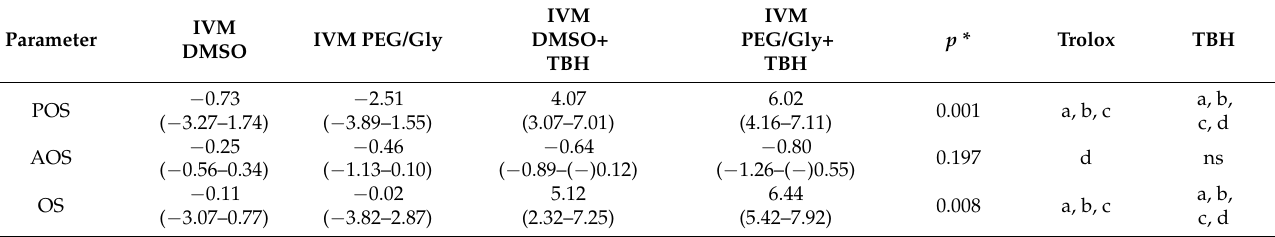
Table 2. POS, AOS and OS of IVM after 2 h.